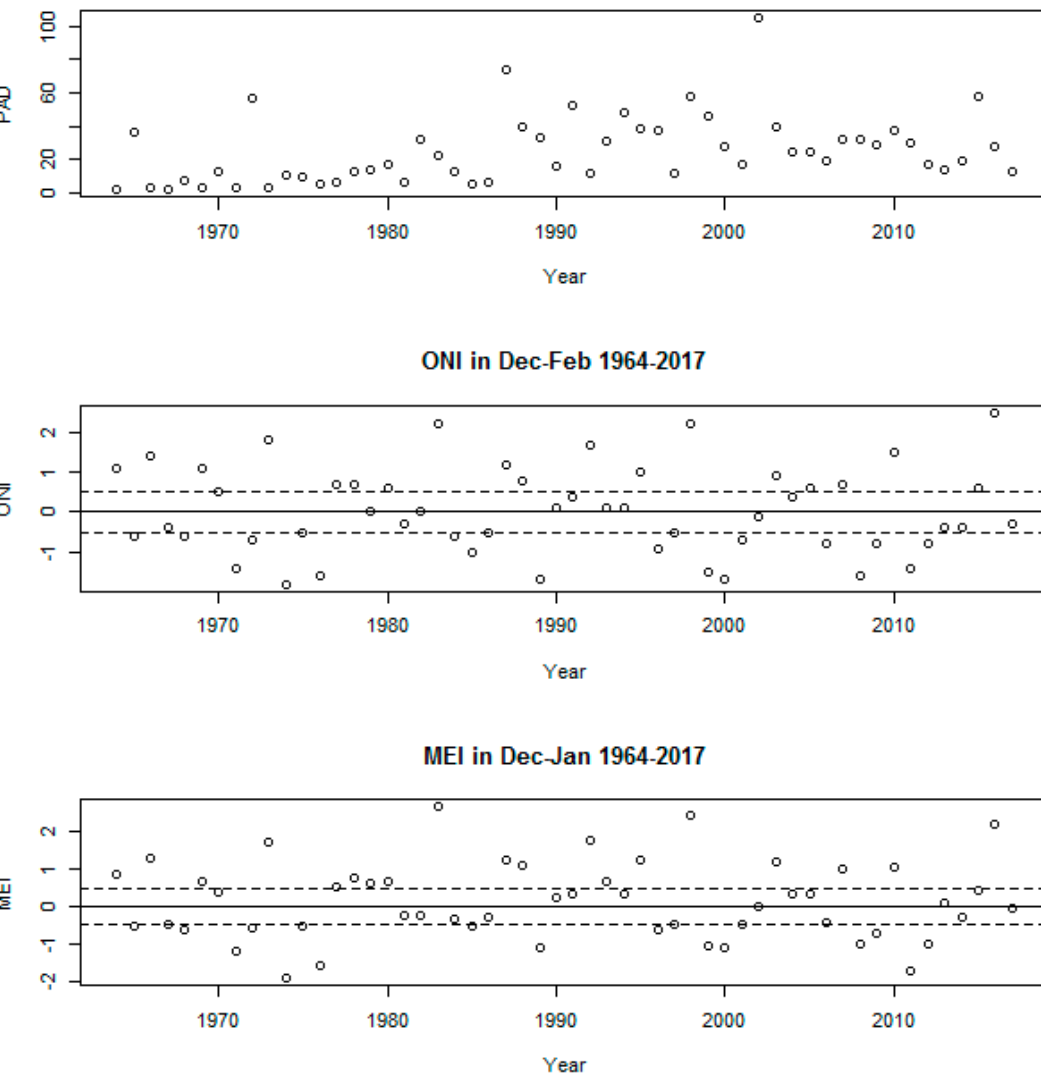
Figure 1. Annual time-series of ONI (DJF), MEI (DJ) and rates of people affected by natural disasters (PAD) (per 1000). Global. Yearly data from NOAA and EM-DAT, 1964–2017.